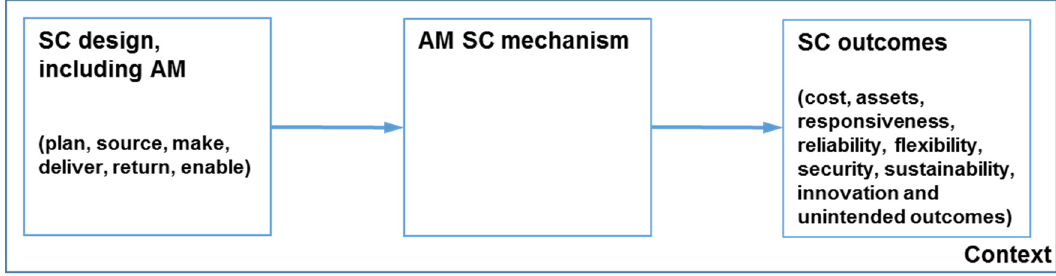
Figure 1. Initial theoretical framework.